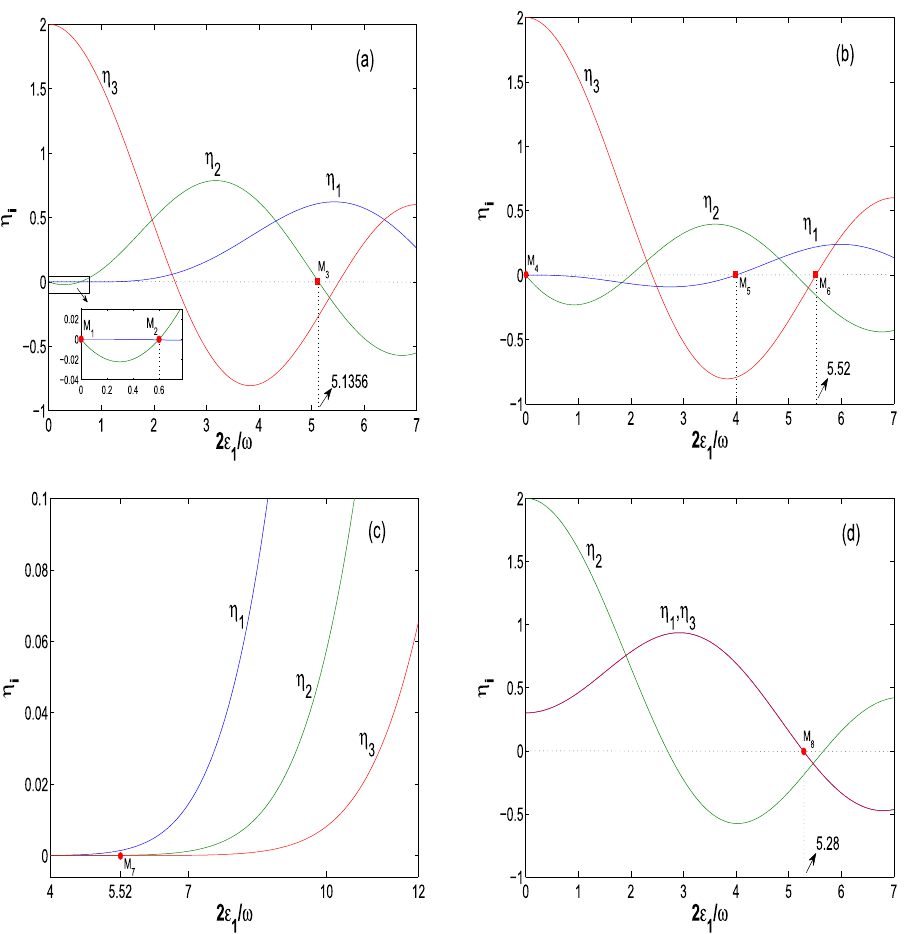
Figure 1. The renormalized coupling coefficients η i as functions of the driving parameter 2 ε 1 / ω for ω = 20, Ω 0 = 1, n = 1 and ( a ) m = l = 1, Ω 1 = 0.3; ( b ) m = l = 1, Ω 1 = 1; ( c ) m = 1, l = − 7, Ω 1 = 1; ( d ) m = 2, l =